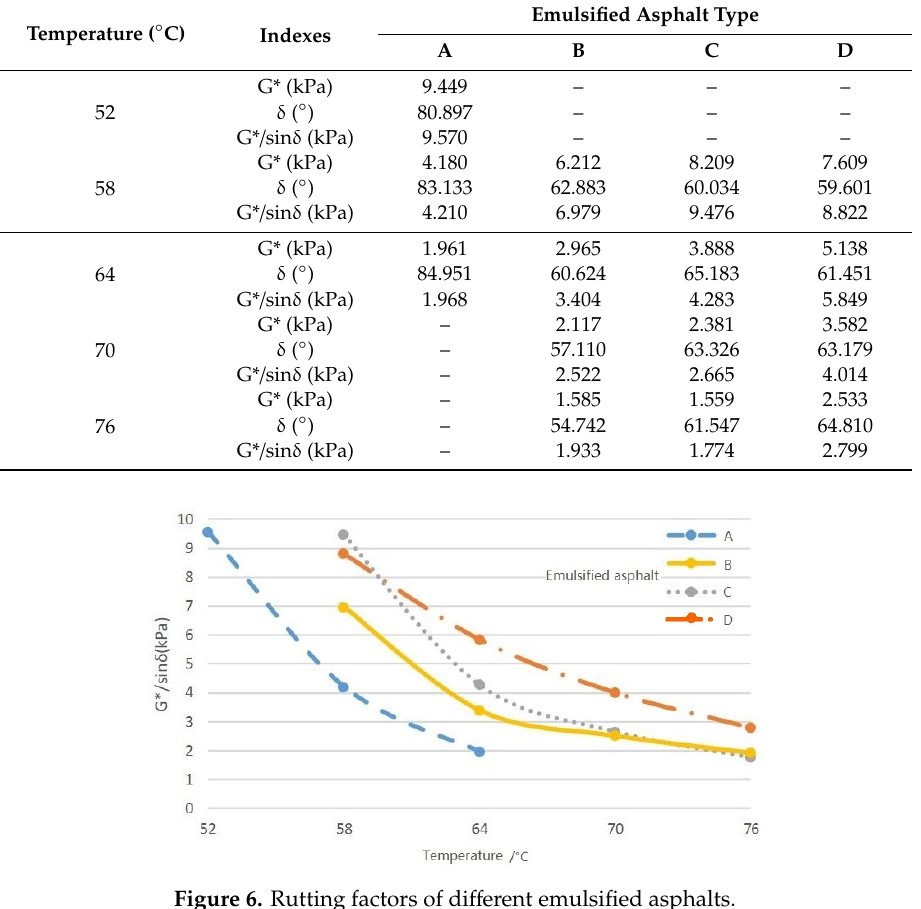
Figure 6. Rutting factors of different emulsified asphalts. Table 4. Results of time sweep test.